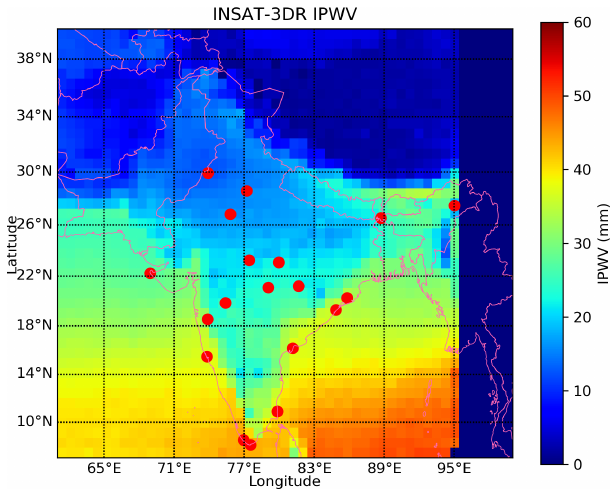
Figure 2. The annual mean of IPWV over India retrieved from INSAT-3DR during the year of 2018. The geographical distribution of 19 GNSS stations (filled red color